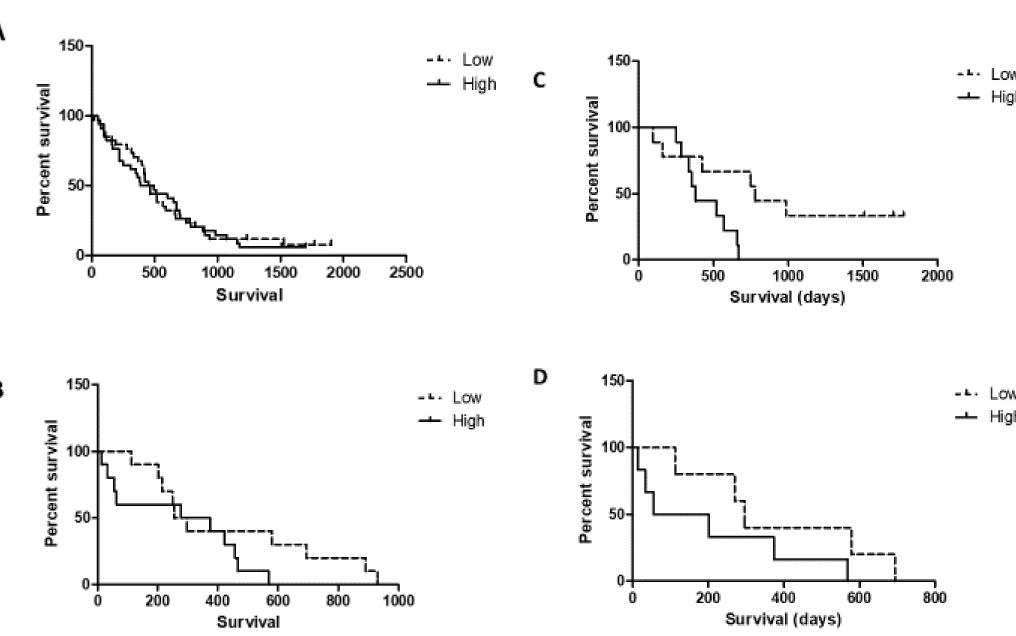
Figure 4. Overall survival analysis of left- and right-sided colorectal cancer patients treated with cetuximab stratified by the median EGFR-HS scores as low versus high of the primary tumors ( N = 88) or metastastatic tissues ( N = 29). ( A ) Left-sided primary tumors N = 69), EGFR HS median = 95. ( B ) Right-sided primary tumors ( N = 19), EGFR HS median = 125. ( C ) Left-sided tumor metastases ( N = 18), median = 80. ( D ) Right-sided tumor metastases N = 11), median = 150. Kaplan–Meyer